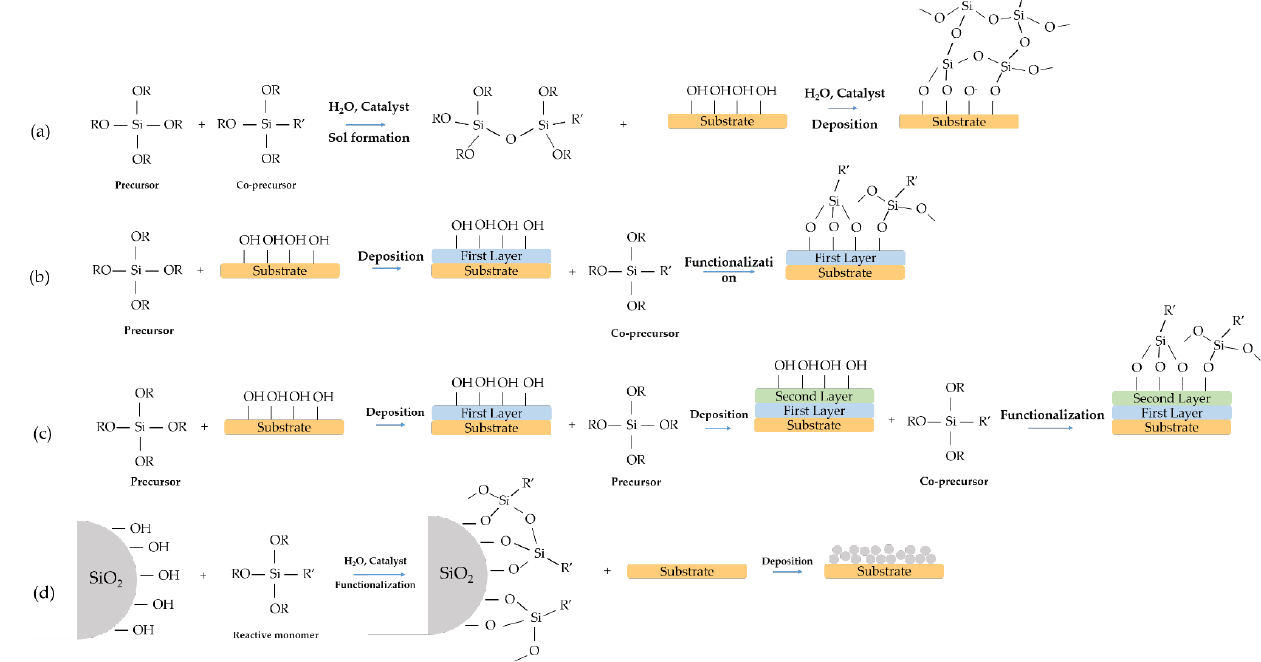
Figure 15. Schematic summary of all synthesis approaches reported in this review: ( a ) one-step synthesis, ( b ) two-step synthesis, ( c ) multilayer synthesis, ( d ) film with modified nanoparticles synthesis.